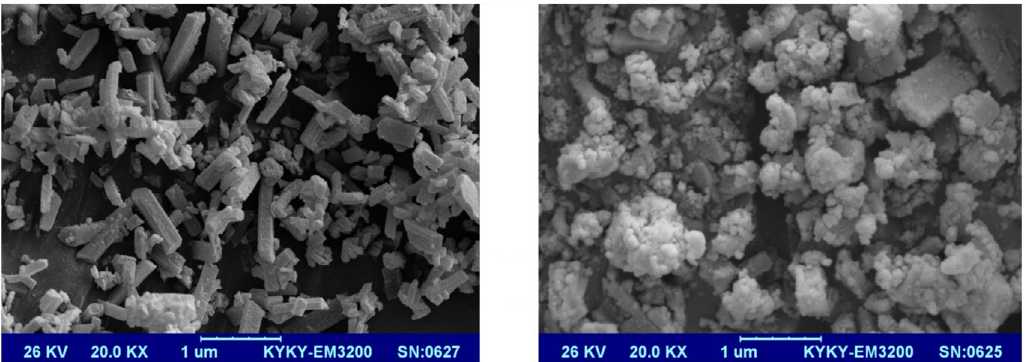
Fig. 2. SEM images of the Ag NPs prepared by (A) maceration and (B) MAE methods, at a magnification of 20.0 K.